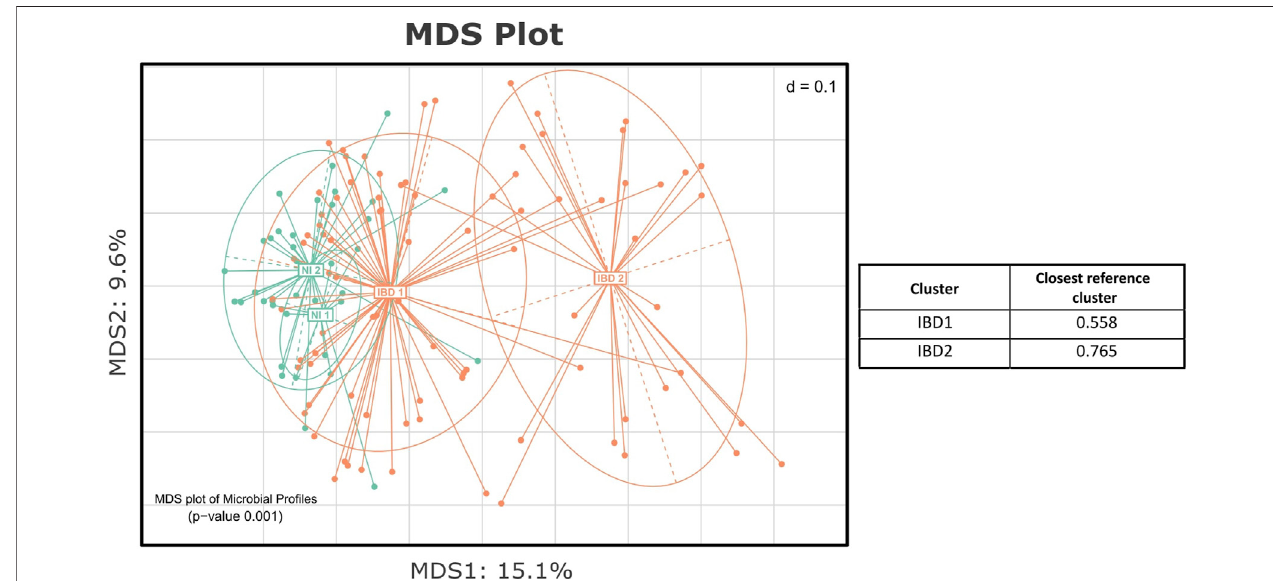
FIGURE 6 | MDS plot presenting the de novo clustering of the NI and IBD groups. Both the NI and IBD samples were clustered into two clusters. The IBD 1 subcluster is closer to the reference groups of the NI, and the IBD 2 is considerably more distant. The table presents the median level of dissimilarity of each IBD cluster from its nearest reference